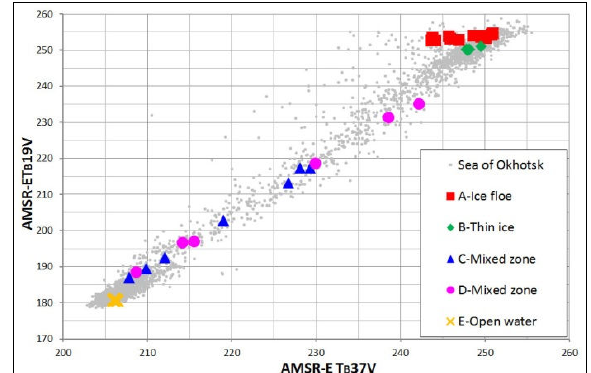
Fig.10 Scatter plots of 19GHz vs 37GHz at V polarization (Sea of Okhotsk, 2009/02/07)